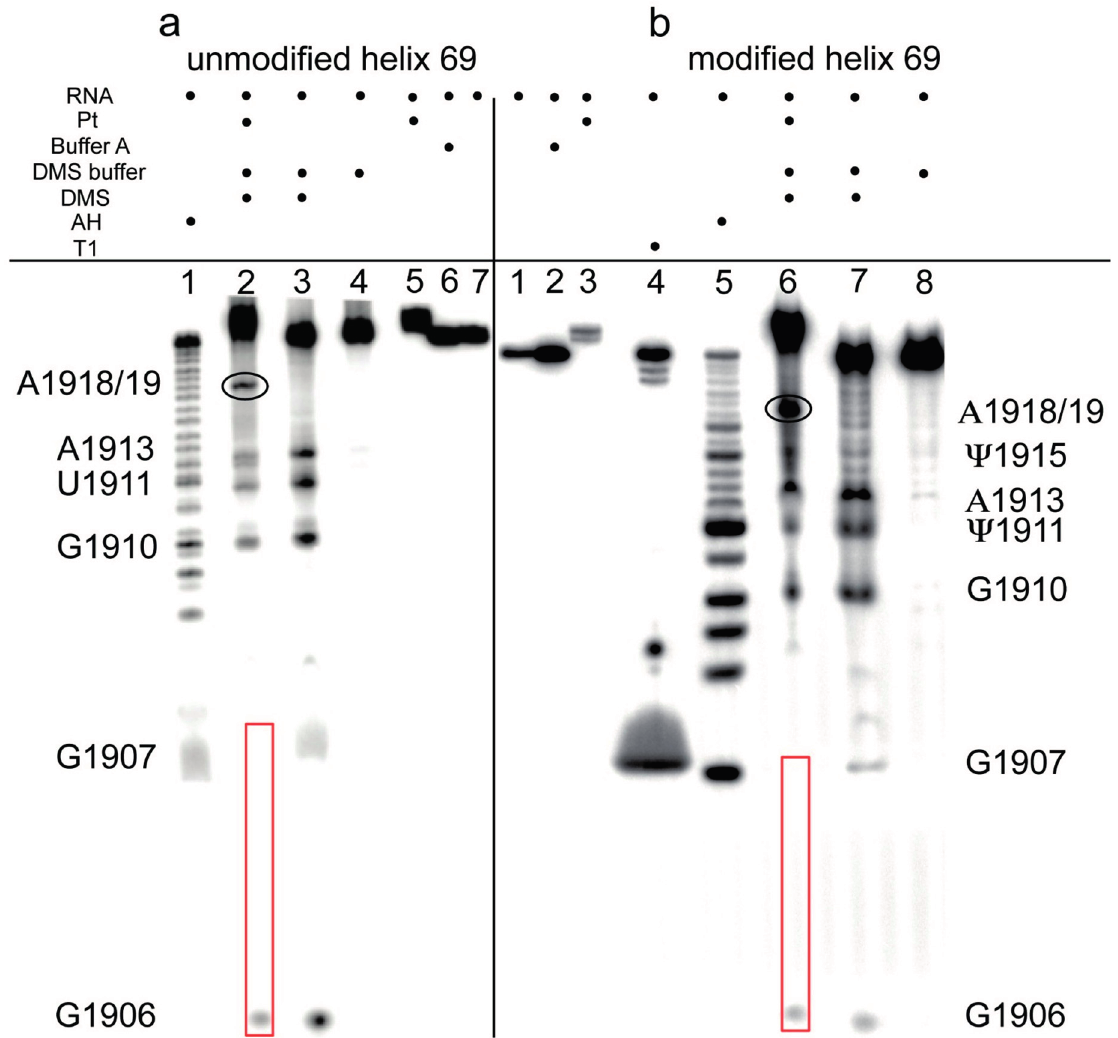
Figure 6. Dimethyl sulfate (DMS) probing of H69 using 5 ′ -labeled RNA is shown. Autoradiograms show the DMS-probing results on 5 ′ -end-labeled ( a ) unmodified H69 and ( b ) modified H69 (T1: RNase T1 reaction on unplatinated RNA; AH: alkaline hydrolysis ladder on unplatinated RNA). Guanine residues that show differences due to platination are indicated with red boxes. Residue A1918/19 (circled) is more sensitive to DMS reactivity following